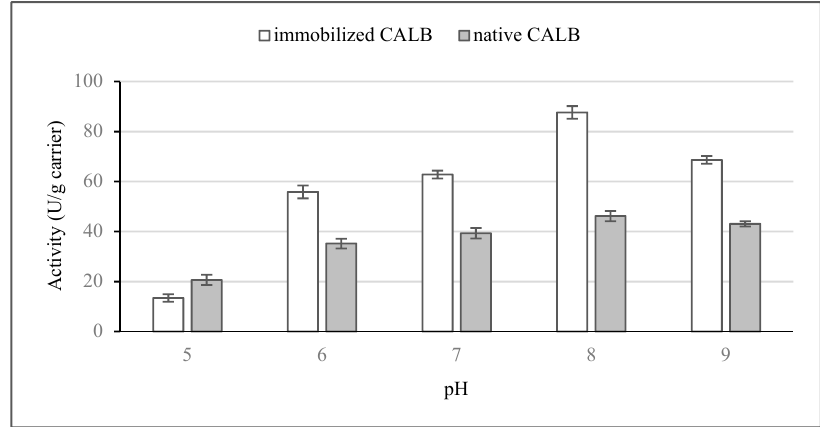
Figure 5. E ff ect of pH on CALB activity (U / g carrier). Reaction conditions: native lipase (1.26 mg) and immobilized CALB onto IB-D152 (50 mg of support), one of the bu ff er solutions: citrate bu ff er (100 mM and pH 5 and 6), phosphate bu ff er (100 mM and pH 7–8), tris-base bu ff er (100 mM and pH 9), the emulsion of gum arabic and olive oil, temperature 37 ◦ C, and incubation 30 min. Data are presented as a means ± standard deviations of three analyses (n = 3). The error bars represent the standard deviations of the mean. To make the results more comparable, the data of enzymatic activity of native form were multiplied 20 times.